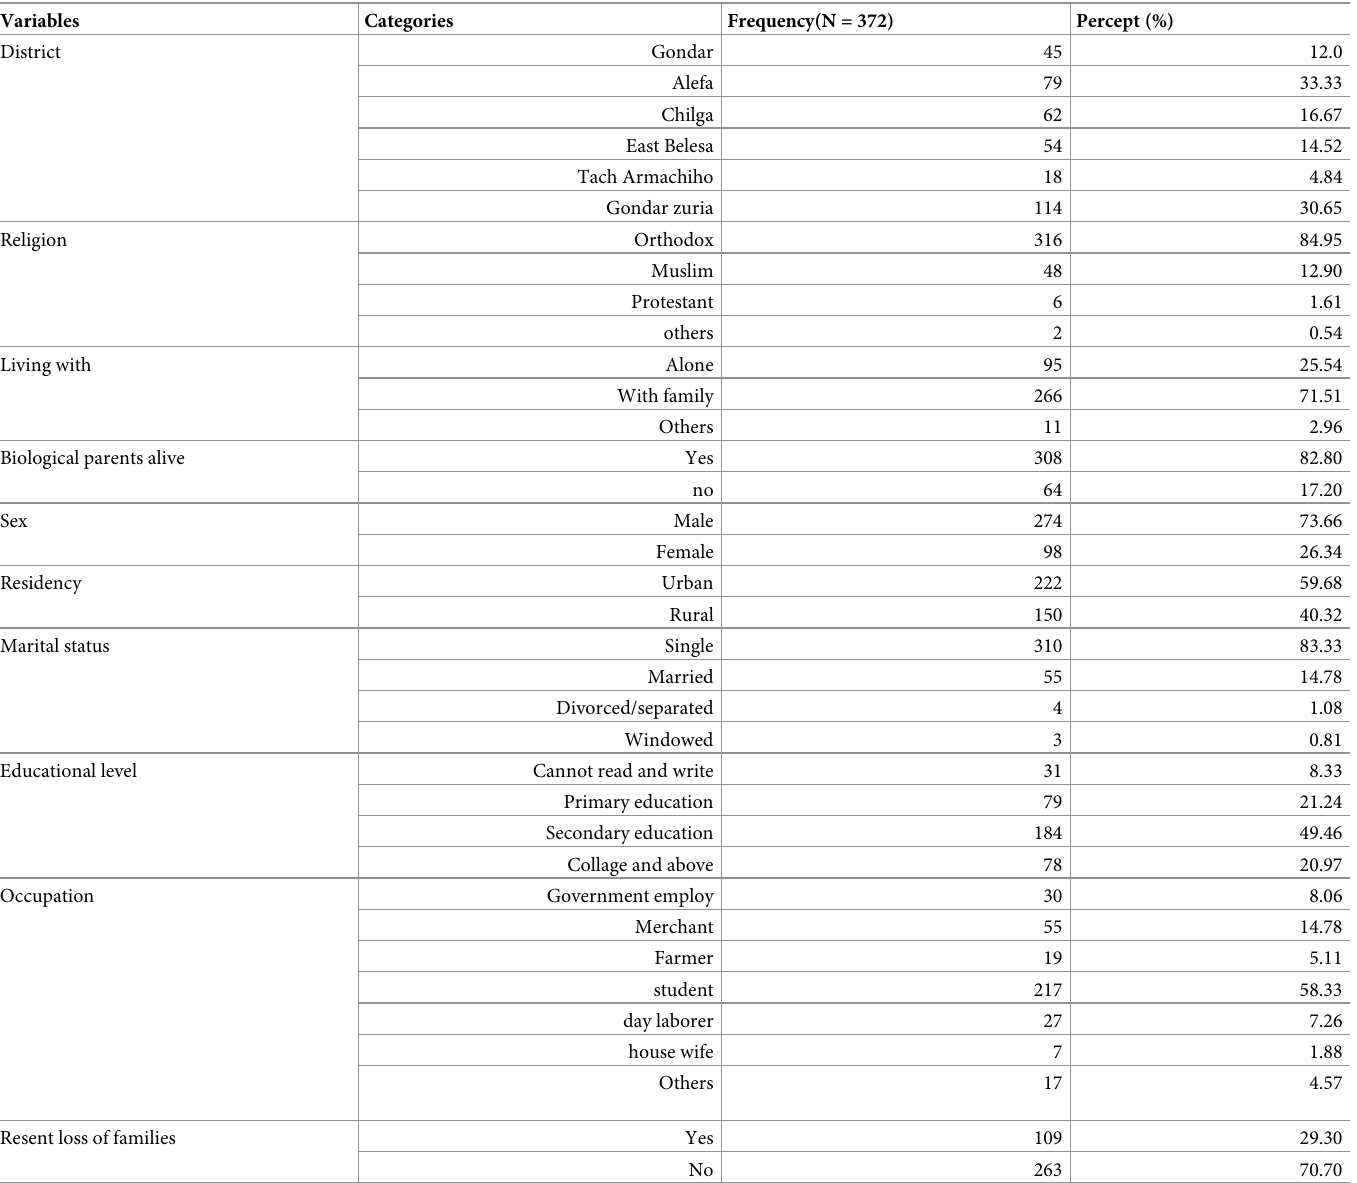
Table 1. Socio-demographic and family-related characteristics of the